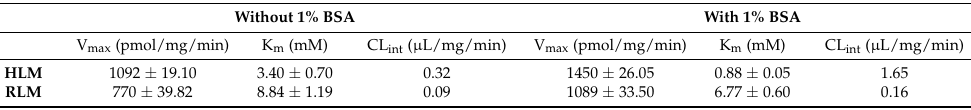
Figure 3. Michaelis-Menten plots for zidovudine (ZDV) glucuronidation catalyzed by ( A ) human liver microsomes (HLM) and ( B ) rat liver microsomes (RLM) with and without 1% ( w / v ) of bovine serum abumin (BSA). Each point represents the mean of zidovudine glucuronides (ZDVG) formation rate ± standard deviation (SD) for triplicates ( n = 3).